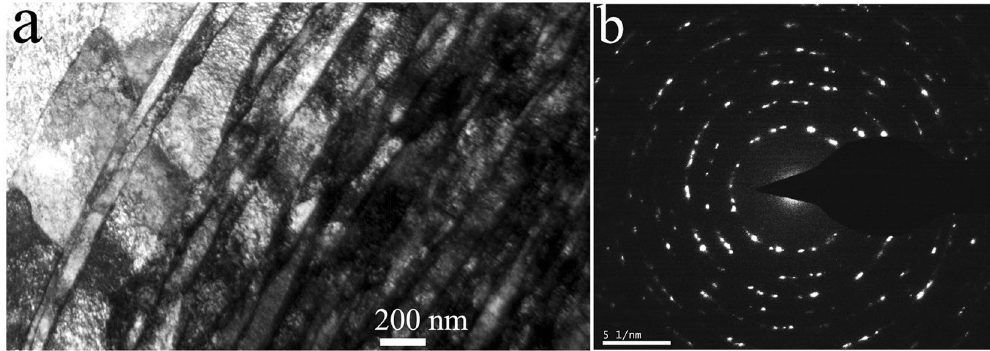
Figure 7. ( a ) Cross-sectional TEM micrograph of the ϕ 1.5 mm ZrO 2 ball SMATed WL10 and ( b ) the SAED pattern taken from ( a ).